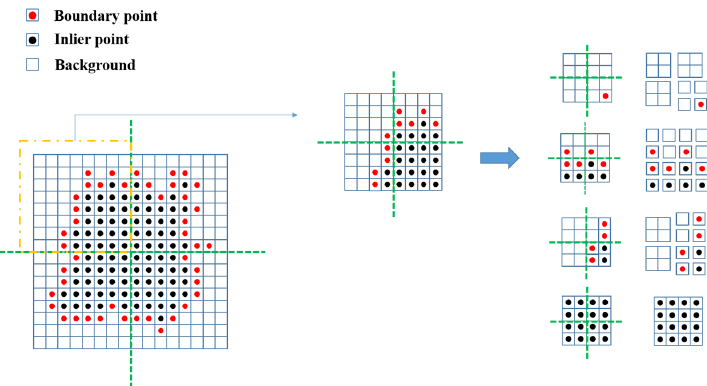
Figure 4. The quadtree segmentation based on cluster fusion.